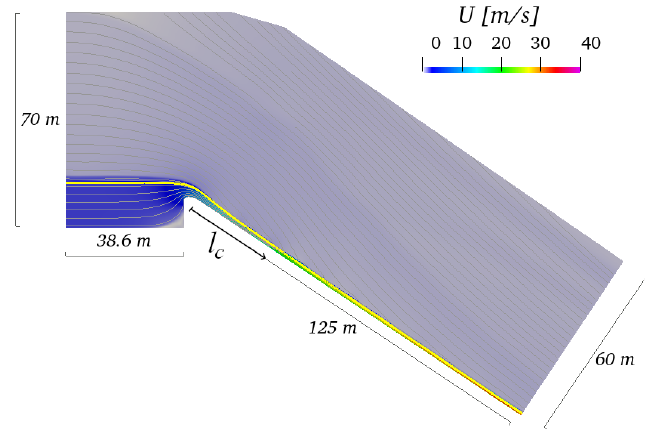
Figure 8. Spillway—longitudinal profile: velocity and water surface (yellow line). The bubble production terms ( P r ) of formulations ‘K’ and ‘S’ are compared. Three profiles perpendicular to the invert – before, near and after the PI (Figure 9)—evidence ν t and k similarities. However, | S | 2 very large gradients at the air–water interface emphasize P S sensitivity to the entrainment surface location, defined by α ent . r After the PI, P K grows approximately linear at the water surface until the end of the r chute (Figure 10). This term is exclusively proportional to k , which is generated at the bottom, and increases continuously before the uniform regime is attained. Contrarily, P S reaches a maximum after 15 m and decreases downstream. Formulation ‘S’ behavior at the water surface is considered incoherent with the arise of the bottom turbulent boundary layer. Therefore, it is classified as inadequate and is not applied on the spillway chute case.